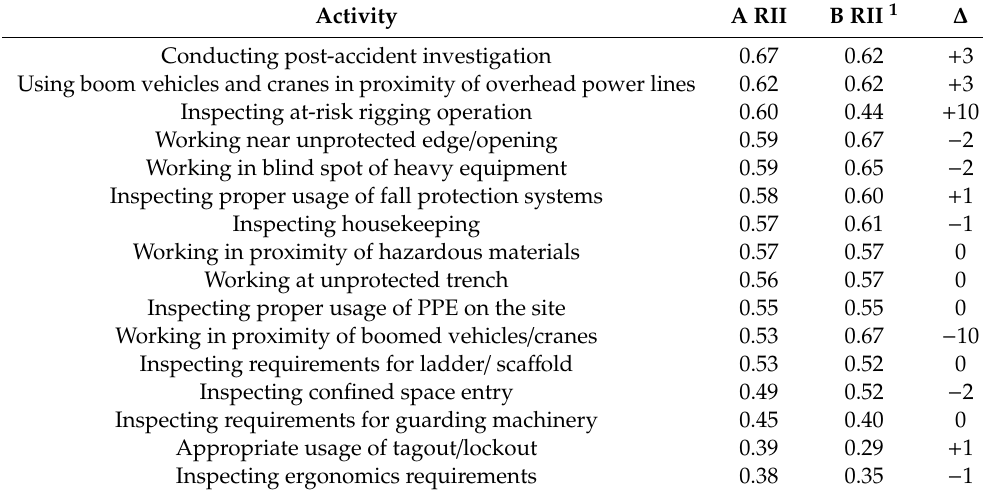
Table 1. E ff ectiveness, frequency, and importance factor for the use of unmanned aerial vehicles (UAVs) at construction